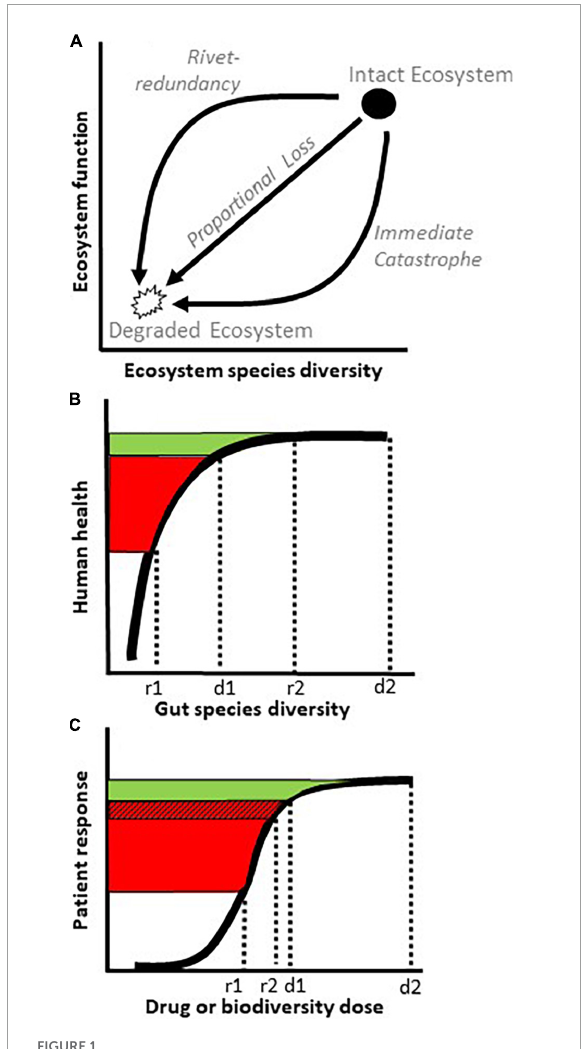
FIGURE1 Curves relating species diversity with ecosystem function or host health. (A) Three ecological relationships between species diversity and ecosystem function. As an ecosystem transitions from an intact state with high diversity (filled circle) to a degraded state with low diversity (open polygon), its function (y axis) could decline via patterns of rivet-redundancy, proportional loss, or immediate catastrophe (arrows). (B) By virtue of its species redundancy, a rivet-redundancy relationship (thick curve), exhibits little increase in function (green) past a species diversity saturation point, d1. In terms of fecal microbiota transplantation (FMT), donors with species diversity d1 and d2 may exhibit roughly similar levels of health on the y axis (green), but incomplete engraftment of microbe diversity from donor d1 to recipient r1 risks a poor health outcome for the recipient (red). No similar risk exists from donor d2 to recipient r2 despite a similar or lower rate of engraftment. (C) In a medical dose-response relationship, drug efficacy flattens above dose d1 (green), similarly to rivet-redundancy in panel (B) . To increase the odds of FMT success, it may not only be beneficial to start with a high diversity donor (d2) but also to implement measures such as antibiotics, colon lavage, or an anti-inflammatory diet that reduce the risks of diversity loss during engraftment, shown here as a smaller gap between d1 and r2 than d1 and r1 and a smaller red hatched area than total red area [ (A,B) adapted from